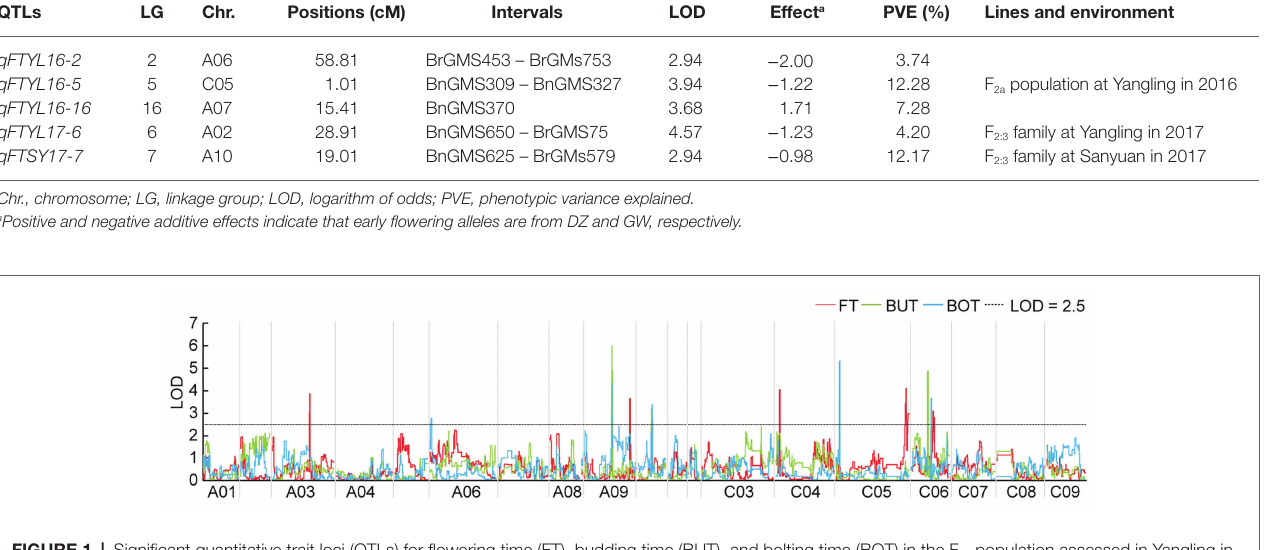
FIGURE 1 | Significant quantitative trait loci (QTLs) for flowering time (FT), budding time (BUT), and bolting time (BOT) in the F 2b population assessed in Yangling in 2018 (YL18). The logarithm odds (LOD) threshold of 2.5 was used to declare the presence of QTL using the QTL IciMapping software. The colors of the identified QTLs are given in the figure. BOT, bolting time; BUT, budding time; FT, flowering time; YL18, the environment of Yangling in 2018.